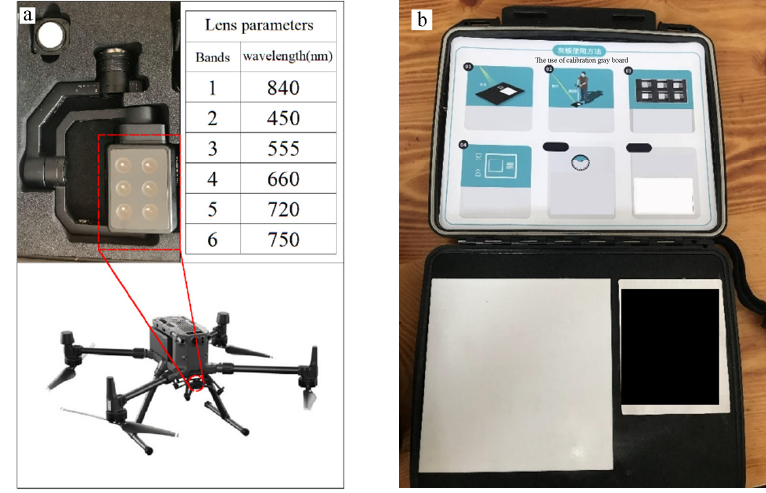
Figure 3. UAV with camera and calibration gray board. ( a ) is UAV with camera, ( b ) is calibration gray board. After UAV aerial photography, samples were collected immediately and the biomass and Sargassum fusiforme were the target species used in this investigation (Figure 4).